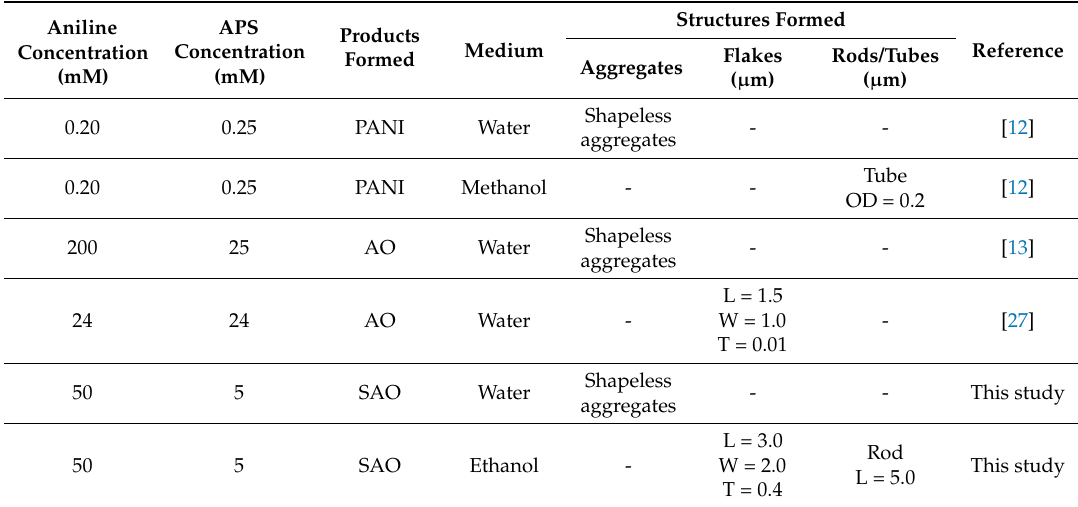
Table 1. Comparison of the microstructures formed using different reaction conditions.